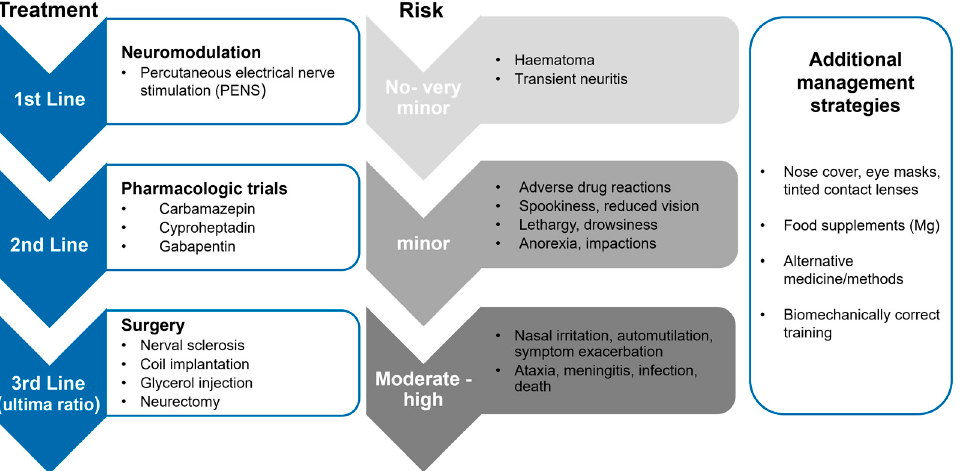
Figure 6. Step-wise recommendations for therapy of horses with chronic idiopathic trigeminal- mediated headshaking. First-line treatments should be applied as therapy of choice due to no to very minor risks. If neuromodulation is not effective, second-line treatments should be initiated. Surgical treatments should only be considered when euthanasia is the only option due to the invasiveness and high risk. Management strategies should be added to all conducted therapies.